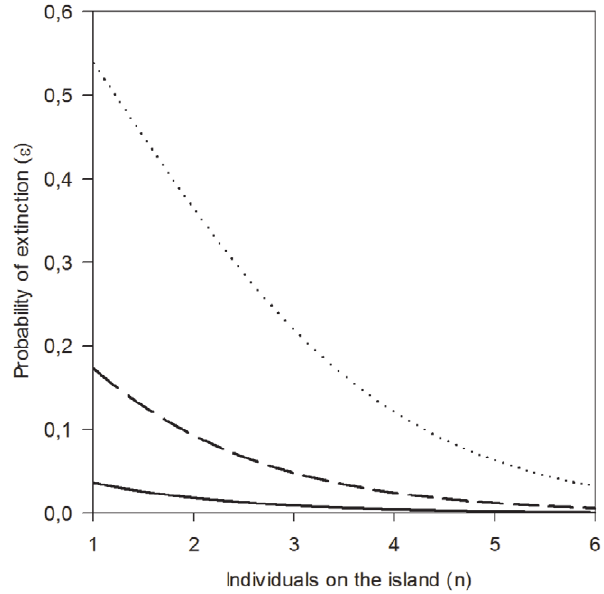
Figure 3. Probability of colonisation. The relationship between the probability of colonisation ( c ), population density index on the mainland the previous season (POPML) and proportion of food and cover on the ground (PFOOD; 5%=solid line, 33%=broken line and 55%=dotted line).